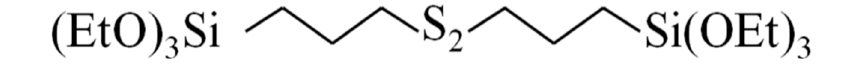
Figure 2. The molecular structure of bis-( γ -triethoxysilylpropyl)-disulfide (TESPD).